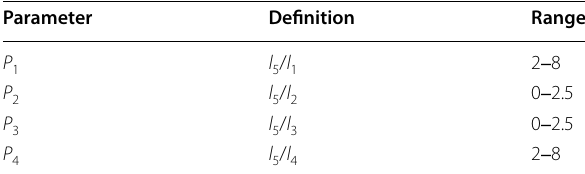
Table 1 Design parameters and their corresponding ranges